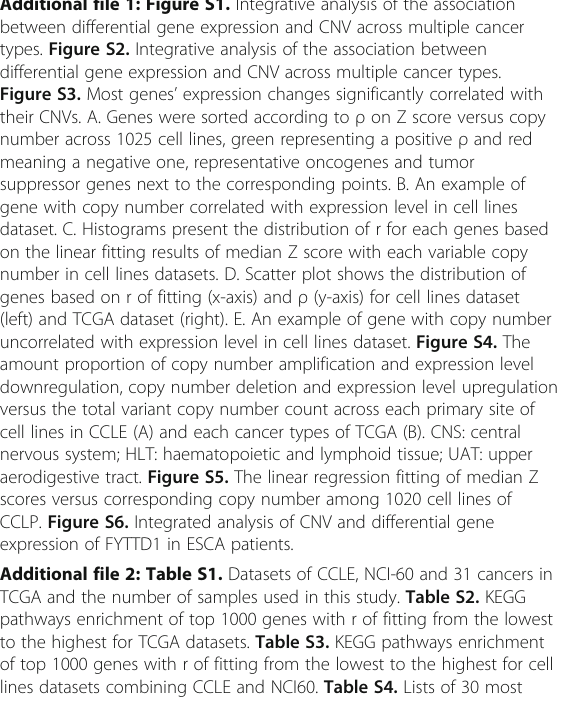
Additional file 1: Figure S1. Integrative analysis of the association between differential gene expression and CNV across multiple cancer types. Figure S2. Integrative analysis of the association between differential gene expression and CNV across multiple cancer types. Figure S3. Most genes ’ expression changes significantly correlated with their CNVs. A. Genes were sorted according to ρ on Z score versus copy number across 1025 cell lines, green representing a positive ρ and red meaning a negative one, representative oncogenes and tumor suppressor genes next to the corresponding points. B. An example of gene with copy number correlated with expression level in cell lines dataset. C. Histograms present the distribution of r for each genes based on the linear fitting results of median Z score with each variable copy number in cell lines datasets. D. Scatter plot shows the distribution of genes based on r of fitting (x-axis) and ρ (y-axis) for cell lines dataset (left) and TCGA dataset (right). E. An example of gene with copy number uncorrelated with expression level in cell lines dataset. Figure S4. The amount proportion of copy number amplification and expression level downregulation, copy number deletion and expression level upregulation versus the total variant copy number count across each primary site of cell lines in CCLE (A) and each cancer types of TCGA (B). CNS: central nervous system; HLT: haematopoietic and lymphoid tissue; UAT: upper aerodigestive tract. Figure S5. The linear regression fitting of median Z scores versus corresponding copy number among 1020 cell lines of CCLP. Figure S6. Integrated analysis of CNV and differential gene expression of FYTTD1 in ESCA patients. Additional file 2: Table S1. Datasets of CCLE, NCI-60 and 31 cancers in TCGA and the number of samples used in this study. Table S2. KEGG pathways enrichment of top 1000 genes with r of fitting from the lowest to the highest for TCGA datasets. Table S3. KEGG pathways enrichment of top 1000 genes with r of fitting from the lowest to the highest for cell lines datasets combining CCLE and NCI60. Table S4. Lists of 30 most